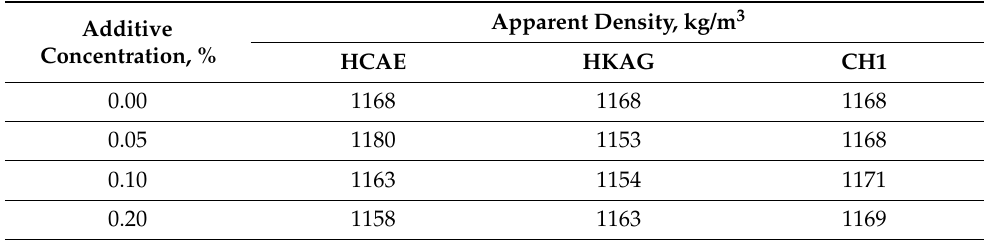
Table 4. Apparent density for gypsum paste with various protein additives.